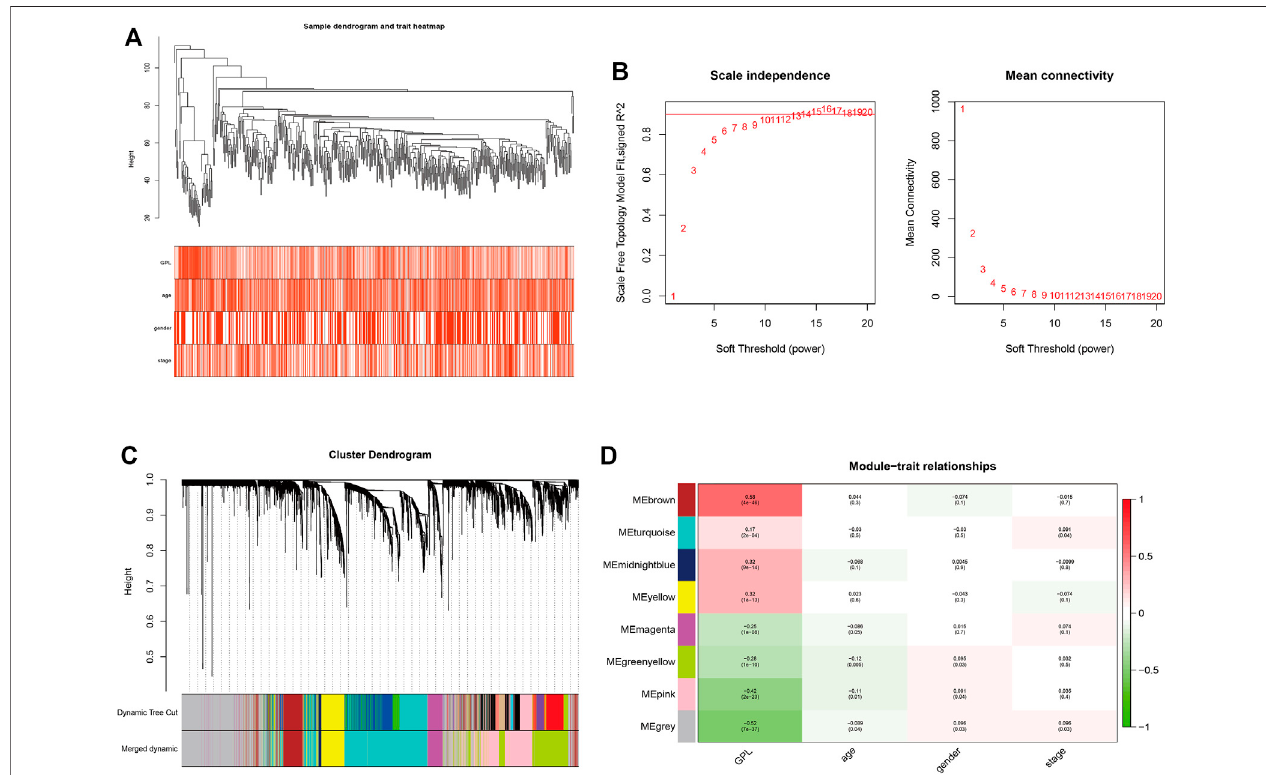
FIGURE 4 | The identi fi cation of GMRHGs with WGCNA. (A) : Hierarchical clustering dendrogram of TCGA CRC patients. (B) : The selection of soft threshold. (C) : The dynamic tree cut dendrogram for TCGA CRC patients. (D) : The correlation between gene module and clinical traits.